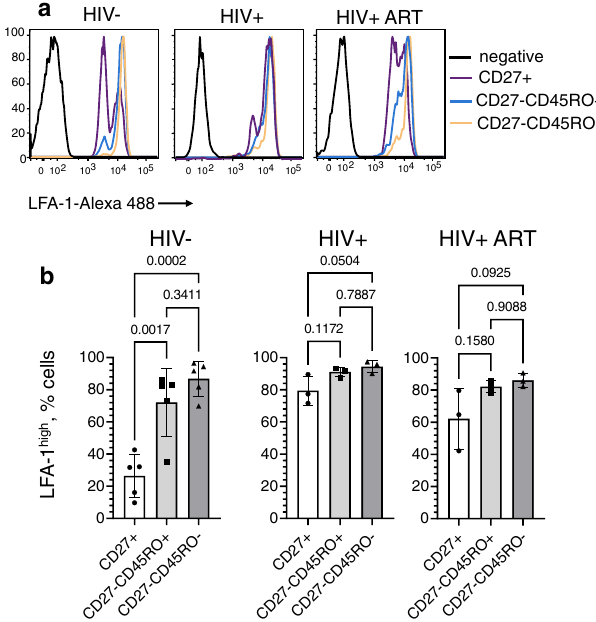
Fig. 3 | CD27+CD8 T cells from donors with chronic HIV infection contain signi fi cantly higher fraction of cells with upregulated LFA-1 expression, and ART treatment only partially reduce the size of the fraction to a normal level. The CD8 T cells subsets were isolated by magnetic sorting, stained with anti-LFA antibodies and analyzed by Flow Cytometry. a Representative fl ow histograms showing LFA-1 expression by CD27+, CD27-CD45RO+ and CD27-CD45RO- CD8 TcellsderivedfromHIV − ,chronicHIV+,andART-treatedHIV+donors. b Frequency of CD8 T cell subsets with high LFA-1 expression for HIV − , chronic HIV+, and ART- treated HIV+ individuals. For each subset, mean with SD shown as bar graph with error bar. Each dot point represent independent experiment; HIV − : N =5, HIV+: N =3, HIV+ART: N =3. Exact p values calculated by ordinary one-way ANOVA with Tukeymultiplycomparisontestandindicatedonthetopofthegraphs.Sourcedata are provided as a source data fi le.